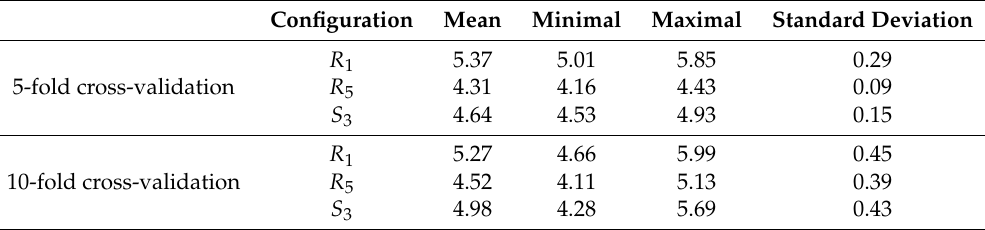
Table 10. Results of performed 5-fold and 10-fold cross-validation on configurations R 1 , R 5 and S 3